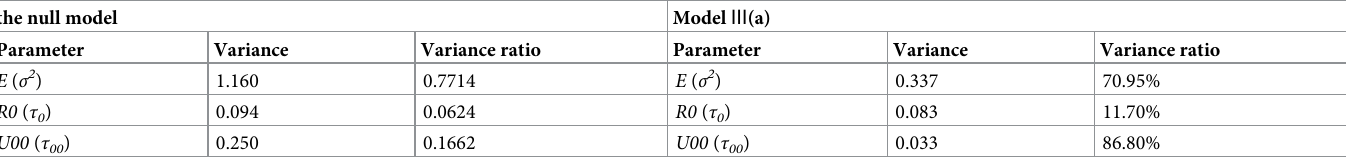
Table 7. The comparison of random effects of the null model and Model III (a). the null